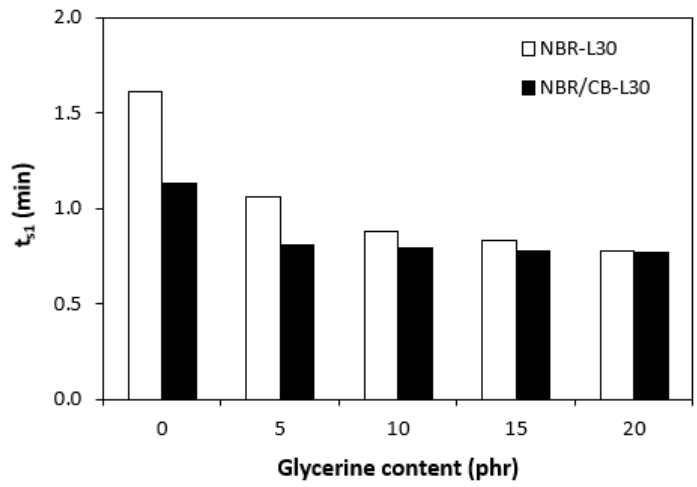
Figure 6. Influence of glycerine contents on scorch times t s1 of rubber compounds.